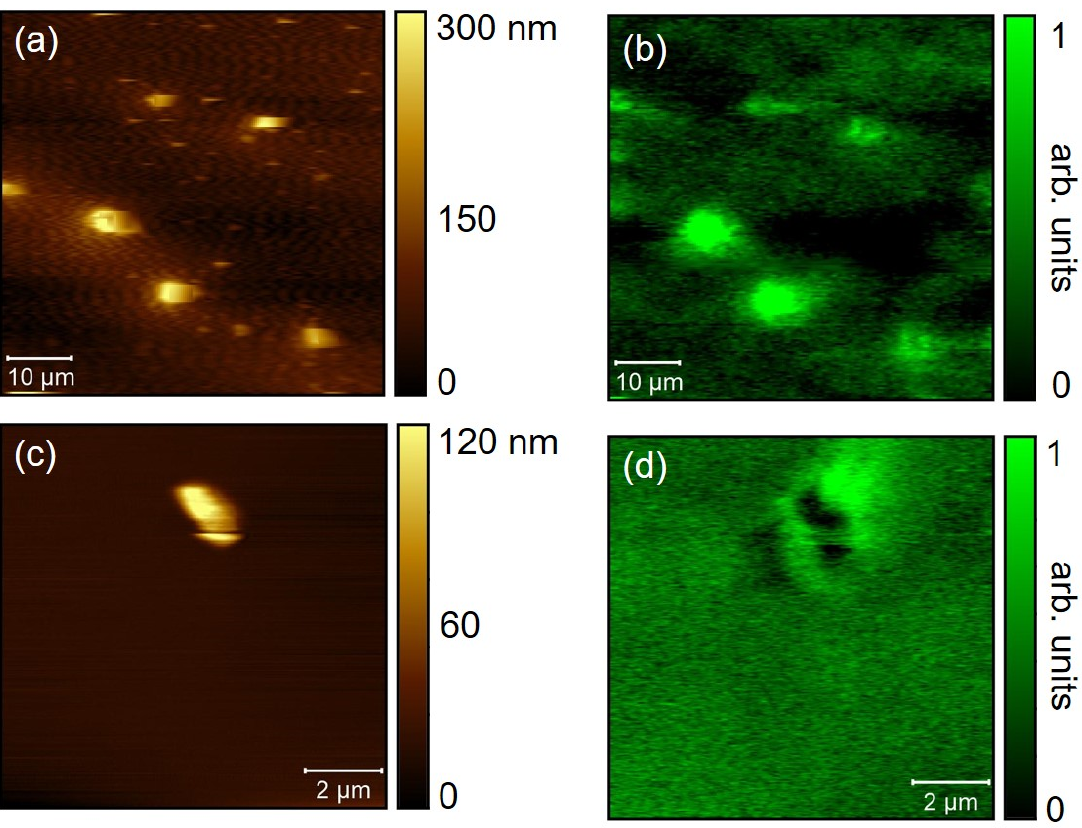
Figure 12. SNOM topography (left) and fluorescence (right) images of FITC-AlgOX (1 mg/mL) deposited on glass via micropipetting. ( a ) and ( b ) refer to FITC-AlgOX concentration of 1 mg/mL; ( c ) and ( d ) refer to FITC-AlgOX concentration of 0.01 mg/mL.